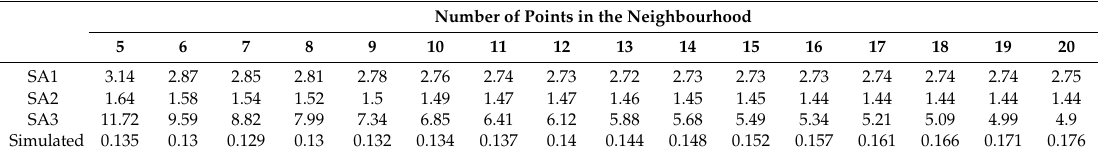
Table 4. Digital elevation model (DEM) root mean square errors (RMSEs) (in meters) of study areas 1-3 and simulated data.